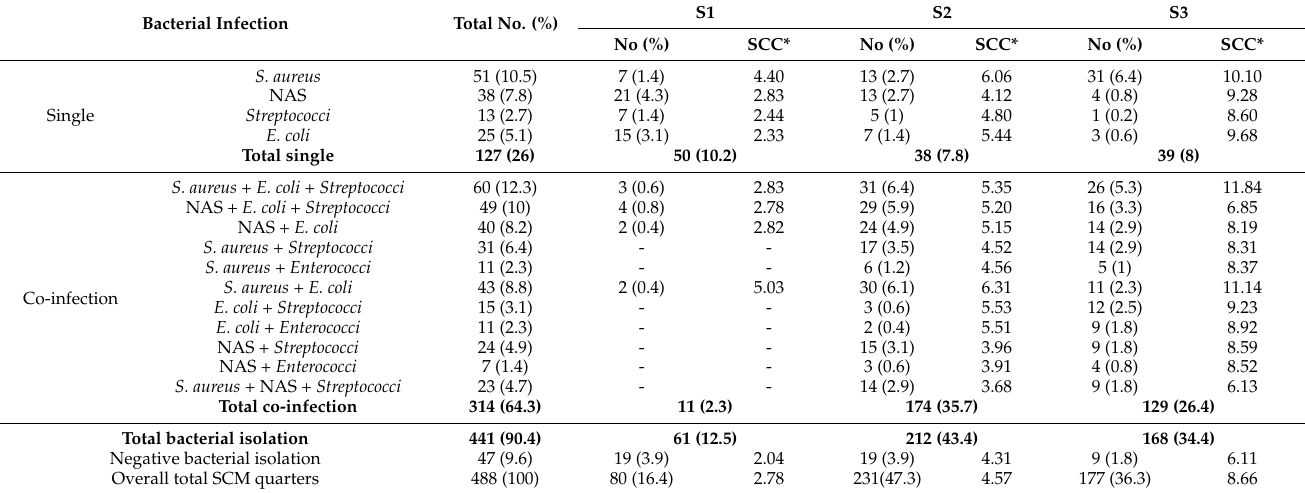
Table 5. Distribution of bacterial pathogens in correspondence to the SCC and CMT. Bacterial